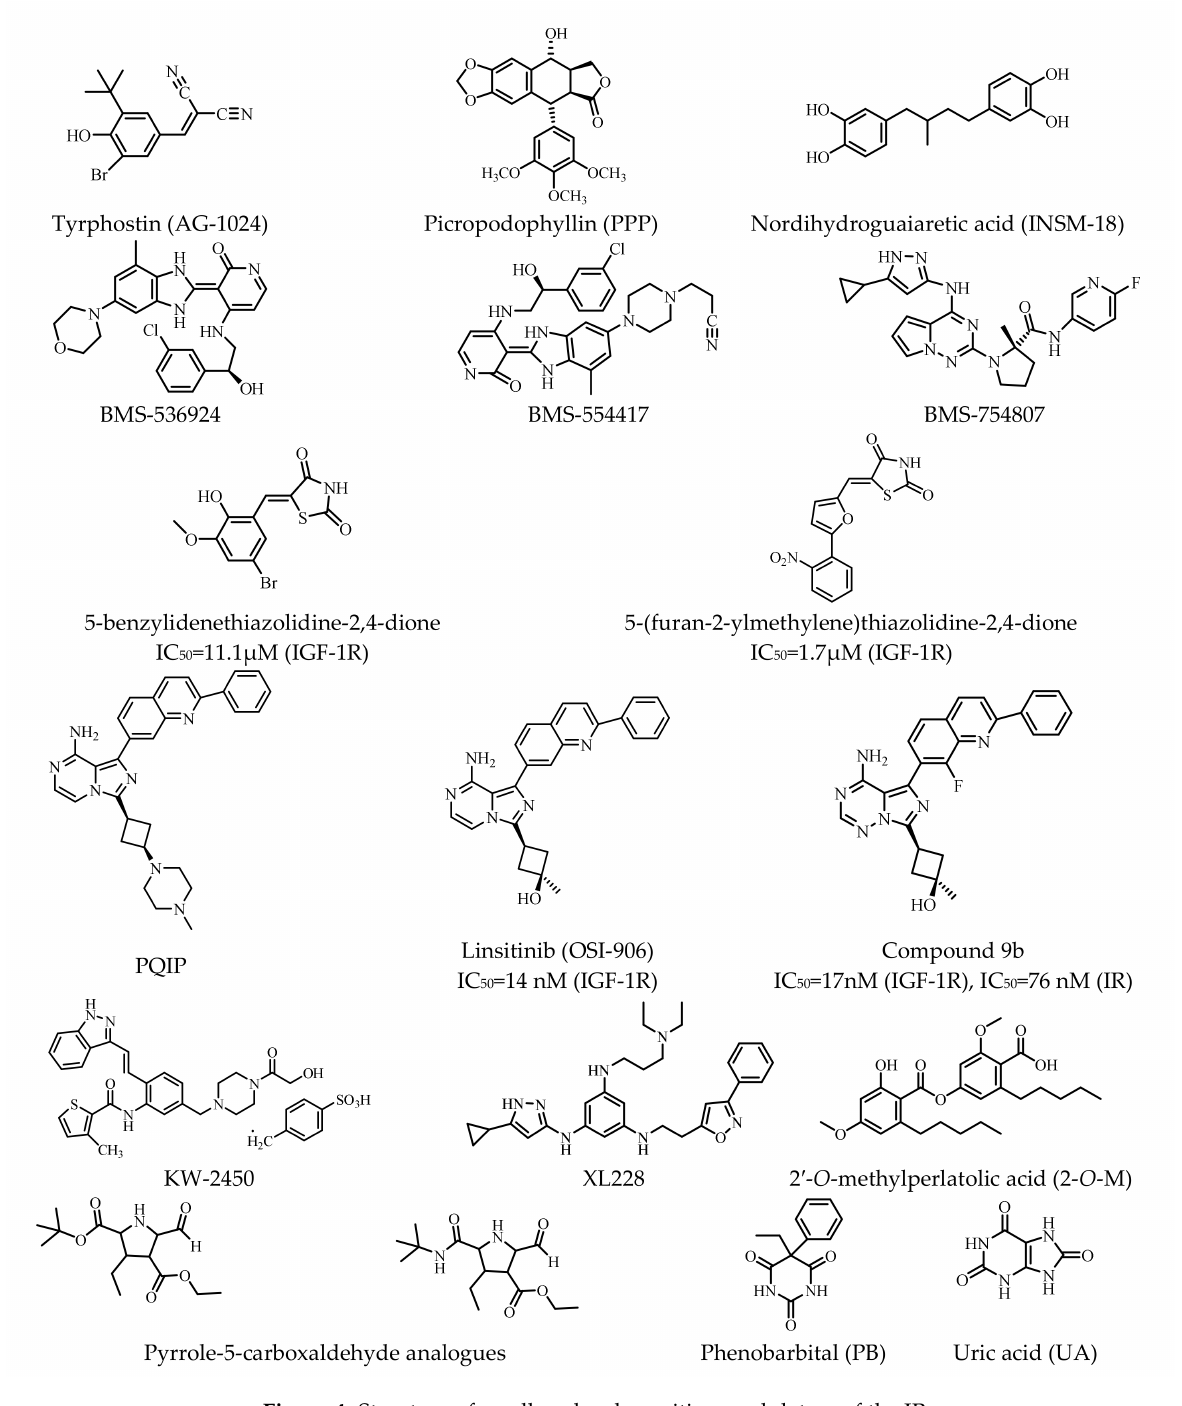
Figure 4. Structure of small-molecule positive modulators of the